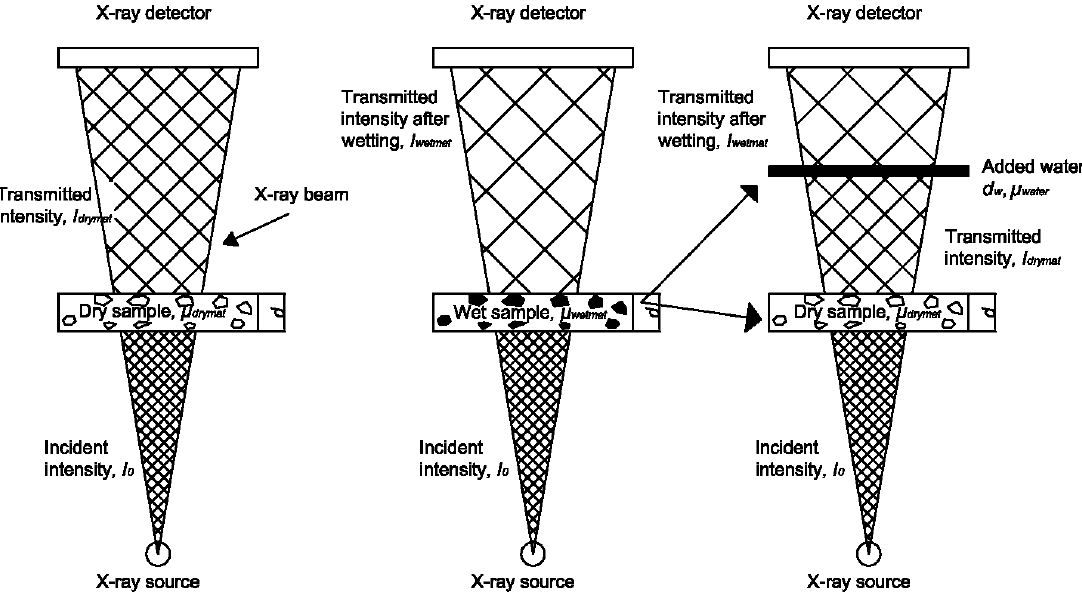
Figure 3. The moisture distribution is obtained by logarithmically subtracting an image of the dry sample I dry from the image of the wet sample I wet , adopted from Reference [10].